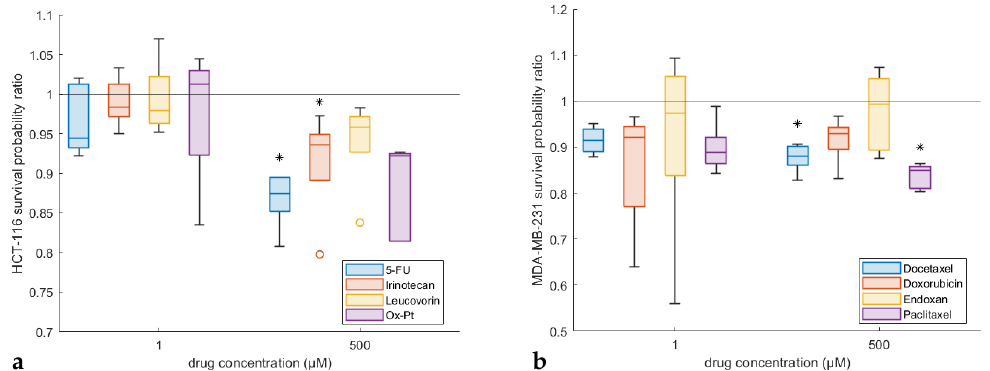
Figure 6. Box plots of the simulation results of the cancer cell survival probability ratio (normalised division probability to normalised apoptosis probability fraction. Plots for ( a ) HCT-116 and ( b ) MDA-MB-231 cell lines, respectively, for every treatment scenario at two extreme drug concentrations. Each scenario is illustrated in a different colour; HCT-116: blue for 5-FU, red for Irinotecan, yellow for Leucovorin, and purple for Ox-Pt drug; MDA-MB-231: blue for Docetaxel, red for Doxorubicin, yellow for Endoxan, and purple for Paclitaxel drug. t -tests at a 5% significance level are denoted with a “*” above corresponding